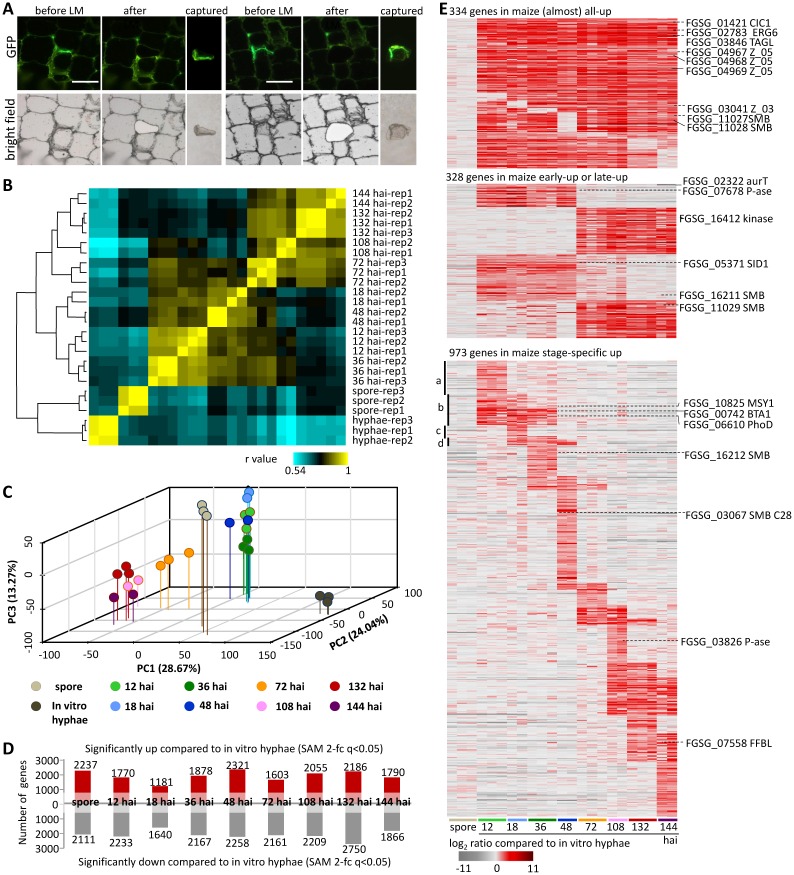
Laser microdissection-derived transcriptomes of F. graminearum in maize stalk.(A) Representative images of laser microdissection (LM) of F. graminearum from infected maize stalk pith at 72 hai (longitudinal sections). White bar = 100 μm. (B) A heat-map representation of the hierarchical clustering using Pearson correlation coefficients. (C) Principal components analysis using microarray data of all 13,346 genes. (D) Numbers of differentially expressed genes between hyphae in maize and hyphae in vitro. (E) Heat maps of genes that were significantly up-regulated in maize compared to in vitro hyphae; see Figure H in S1 Text for more.